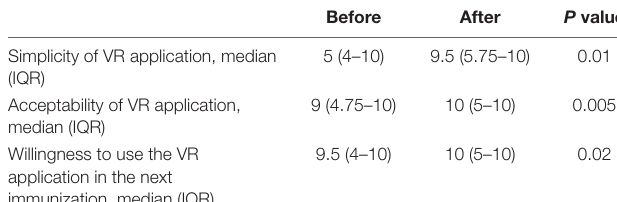
TABLE 3 | Nurses’ perspectives of using VR in childhood immunization (intervention